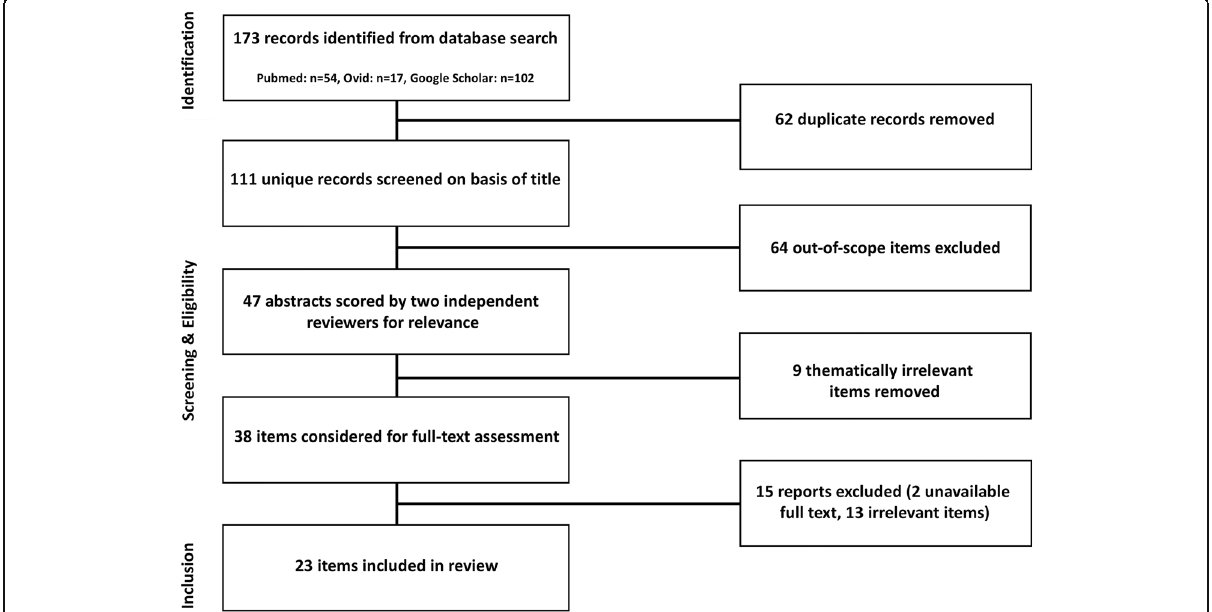
Fig. 1 Flow chart of literature review process. Literature search was conducted using the databases PubMed, Ovid and Google Scholar, and search terms multiple sclerosis and human immunodeficiency virus or HIV or AIDS or antiretroviral therapy, to identify articles written in English or German, between 1985 and 2019. Two independent reviewers carried out the selection of the